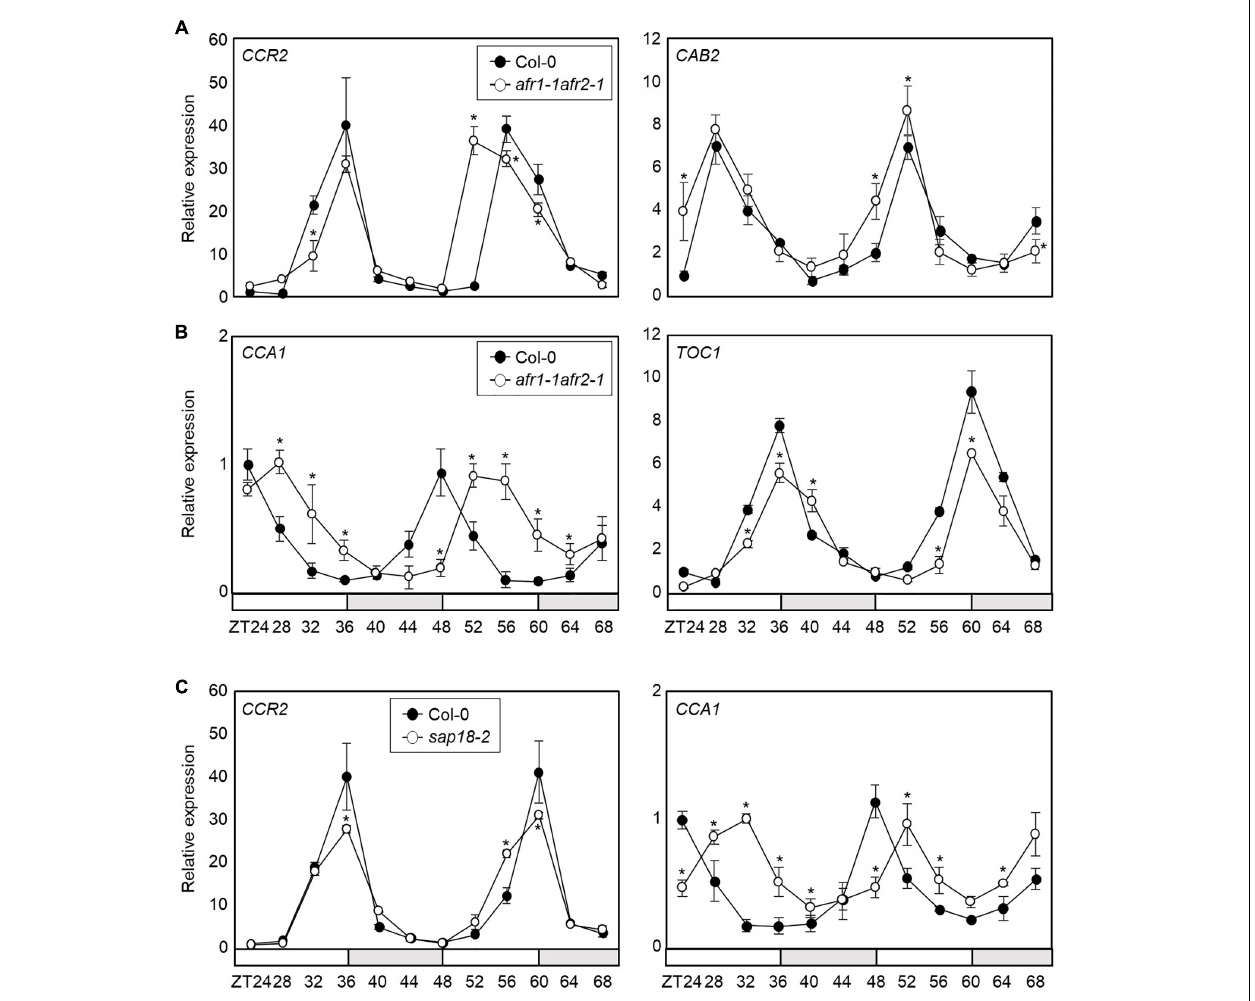
FIGURE 4 | Altered circadian rhythm in the afr1-1afr2-1 mutant. In (A–C) , seedlings grown under ND were transferred to LL at ZT0. Whole seedlings were harvested from ZT24 to ZT68 to analyze transcript accumulation. Gene expression values were normalized to eIF4A expression and represented as n -fold compared to the value of the wild-type sample at ZT24. Three independent biological replicates were averaged, and statistically significant differences (Student’s t -test, ∗ P < 0.05) are indicated by asterisks. Bars indicate the standard error of the mean. The white and pale gray boxes indicate the subjective day and night, respectively. (A) Expression of CCR2 and CAB2 in afr1-1afr2-1 . (B) Expression of CCA1 and TOC1 in afr1-1afr2-1 . (C) Expression of CCA1 and CCR2 in sap18-2